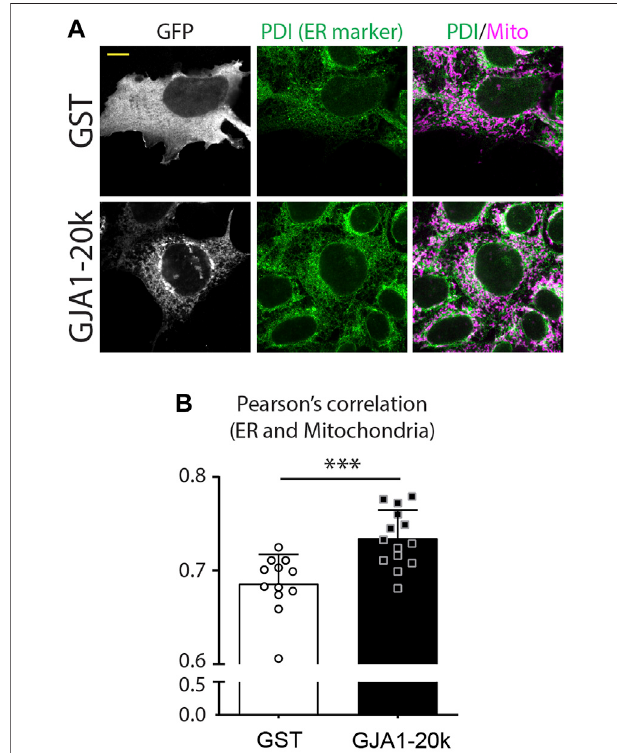
FIGURE 3 | GJA1-20k increases interaction between ER and mitochondria. (A) Representative fi xed-cell images of ER and mitochondria in GFP-tagged GJA1-20k (or GST as control) transfected HeLa cells. ER and Mitochondria are visualized by PDI and Tom20 antibodies, respectively. Scale bars, 10 μ m. (B) The quanti fi ed Pearson ’ s correlation between ER and Mitochondria with or without exogenous GJA1-20k. n = 12 (GST) or 14 (GJA1-20k) cells. Graphs are expressed as mean ± SD. p value is determined by two-tailed Mann-Whitney U -test. *** p < 0.001. **These fi gures are published in Reference (Shimura et al., 2021b) as a response to Reviewer ’ s comments for the corresponding eLife publication (Shimura et al.,